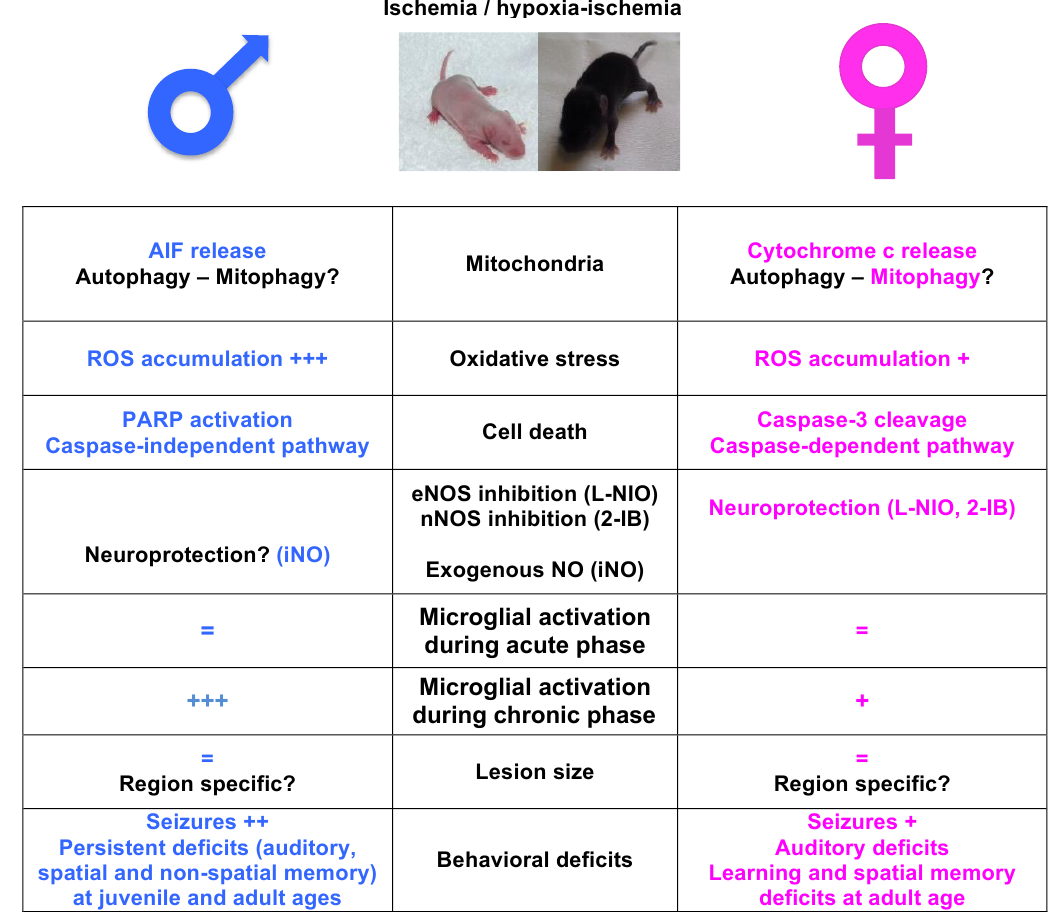
Figure 1. Schematic illustration of sexual dimorphism pathways after neonatal ischemia and hypoxia-ischemia. Major molecular pathways, including the lesion size and behavioral deficits ( middle column), in male ( blue , left column) and female ( pink , right column), with relative agreements in the literature. In black, lack of consensus in the literature and/or single report. AIF: apoptosis inducing factor; eNOS: endothelial nitric oxide synthase; nNOS: neuronal NOS; iNO: inhaled NO; ROS: reactive oxygen species.